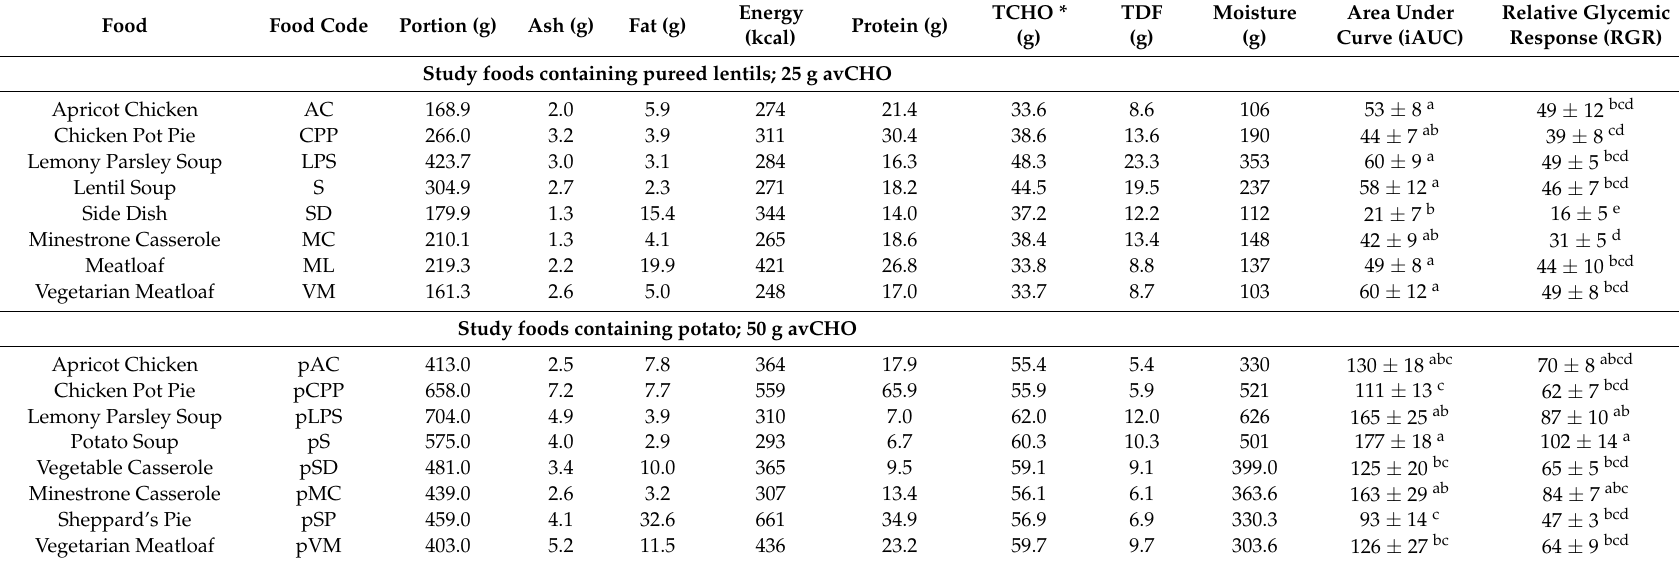
Table 3. Nutritional composition of food items and measures of glycemic